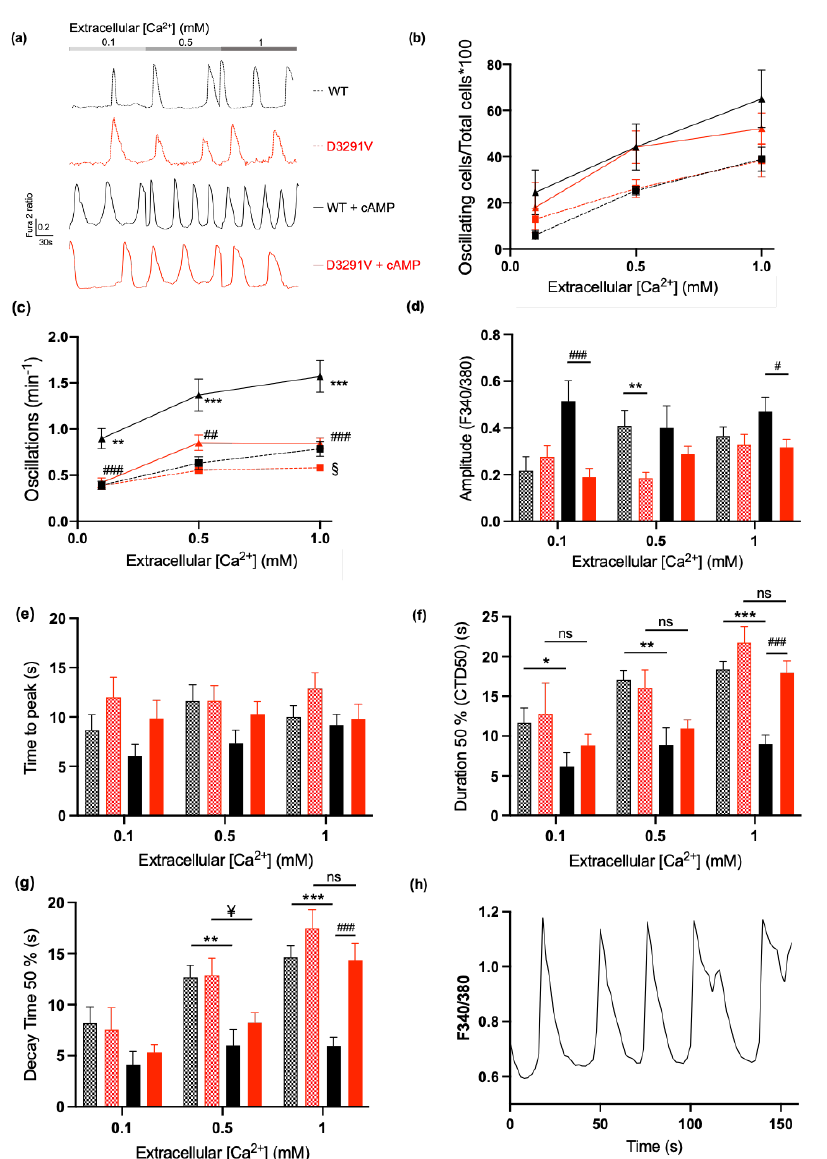
Figure 6. Dominant effect of D3291V in HL-1 cardiomyocytes: ( a ) Representative traces of Ca 2+ release under basal conditions and after cAMP treatment. ( b ) Percentages of oscillating WT-RyR2 cells (n = 4 dishes) and D3291V-RyR2 cells (n = 5 dishes) at different Ca 2+ concentrations (0.1, 0.5, 1 mM) under basal conditions or challenged by 250 µ M cAMP. WT: black squares and dotted lines; WT + cAMP: black triangles and solid lines; D3291V: red squares and dotted lines; D3291V + cAMP: red triangles and solid lines. ( c ) Number of oscillations per minute of WT-RyR2 (n = 90 cells) or D3291V-RyR2 cells (n = 209 cells) at different Ca 2+ concentrations (0.1, 0.5, 1 mM) under basal conditions or challenged by 250 µ M cAMP. ( d ) Amplitude of the Ca 2+ released at each spontaneous oscillation at different Ca 2+ concentrations (0.1–1 mM) under basal conditions or challenged by 250 µ M cAMP. ( e ) Time to peak at different Ca 2+ concentrations (0.1–1 mM) under basal conditions or challenged by 250 µ M cAMP. ( f ) Calcium transient duration at 50% (CTD50) at different Ca 2+ concentrations (0.1–1 mM) under basal conditions or challenged by 250 µ M cAMP. ( g ) Decay time 50% at different Ca 2+ concentrations (0.1–1 mM) under basal conditions or challenged by 250 µ M cAMP. ( h ) Representative trace of Ca 2+ release of D3291V-RyR2 cells after cAMP treatment at 0.5 mM of extracellular Ca 2+ . WT compared to D3291V: § p < 0.05. WT compared to WT + cAMP: * p < 0.05, ** p < 0.01, *** p < 0.001. D3291V compared to D3291V + cAMP: ¥ p < 0.05. WT + cAMP compared to D3291V + cAMP: # p < 0.05, ## p < 0.01, ### p <